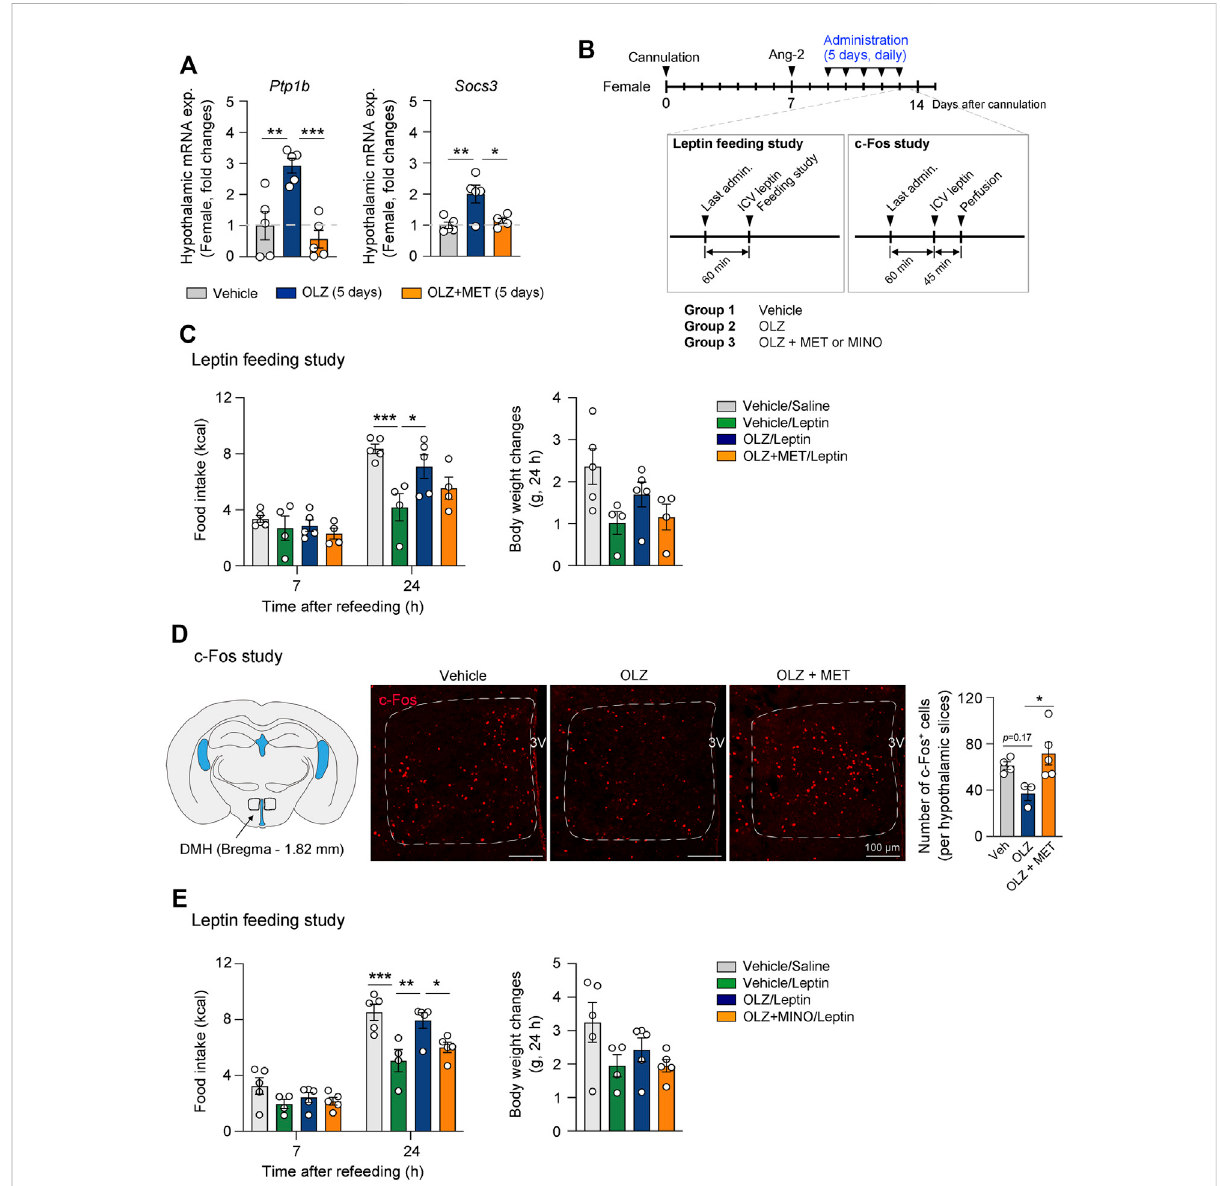
FIGURE 5 Olanzapine (OLZ)-induced leptin resistance was reversed by metformin (MET) and minocycline (MINO). (A) Effect of OLZ or OLZ + MET treatment on hypothalamic Ptp1b and Socs3 mRNA expression in female mice ( n = 4 – 5). (B) Experimental scheme pertaining to mice that were administered OLZ, OLZ + MET, or OLZ + MINO. (C,E) Food intake and body weight changes after leptin injection in female mice administered OLZ, OLZ + MET, or OLZ + MINO for 5 days ( n = 4 – 5). (D) The numbers of c-Fos + cells in the dorsomedial hypothalamus (DMH) of female mice treated with OLZ or OLZ + MET for 5 days ( n = 3 – 5). Data are presented as mean ± SEM values. Statistical analyses were performed using one-sided one-way analysis of variance (ANOVA) (A,D) and one-sided two-way ANOVA (C,E) followed by a post hoc least signi fi cant difference (LSD) test. * p < 0.05, ** p < 0.01, and *** p < 0.001 between the indicated groups. Scale bars: 100 μ